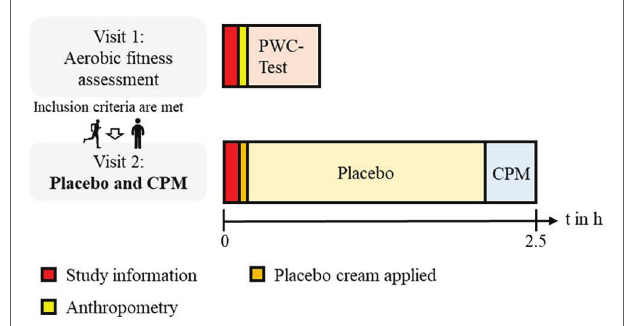
FIGURE 2 | Study design. Using a within-subject design, each participant was investigated on 2 separate days. On visit 1, a PWC test was conducted, and on visit 2 the main experiment (placebo paradigm and CPM paradigm) took